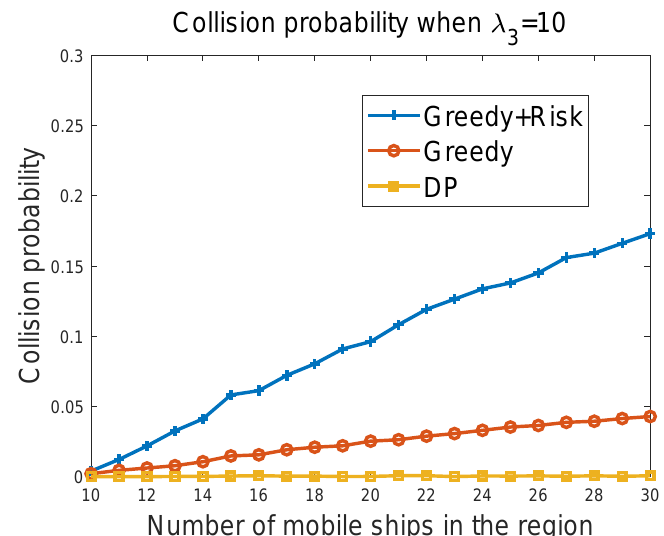
Figure 8. Collision probability vs. ship density when λ 3 = 10.